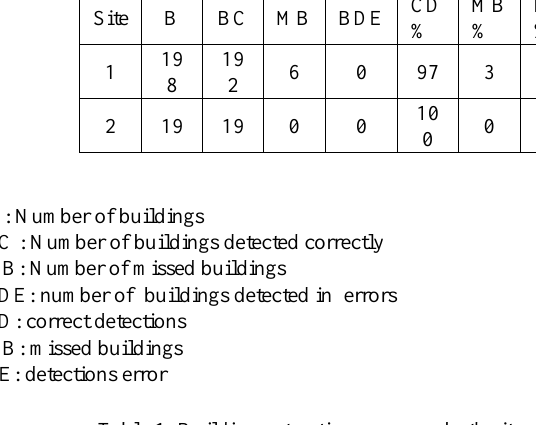
Table 1: Building extraction errors on both